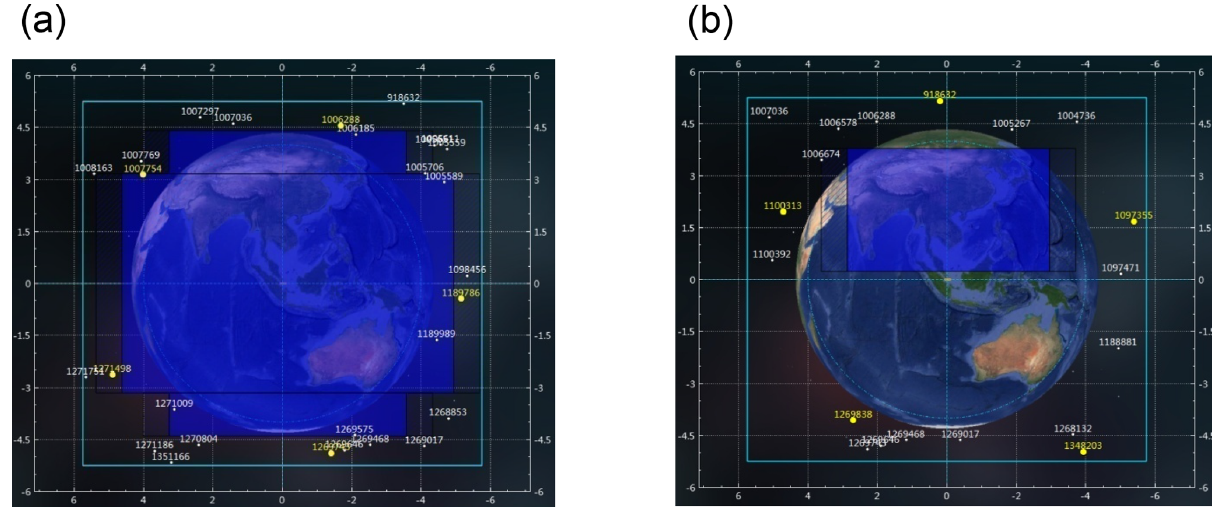
Figure 7. AGRI typical tasks: (a) full-disk observation and (b) Chinese region observation.